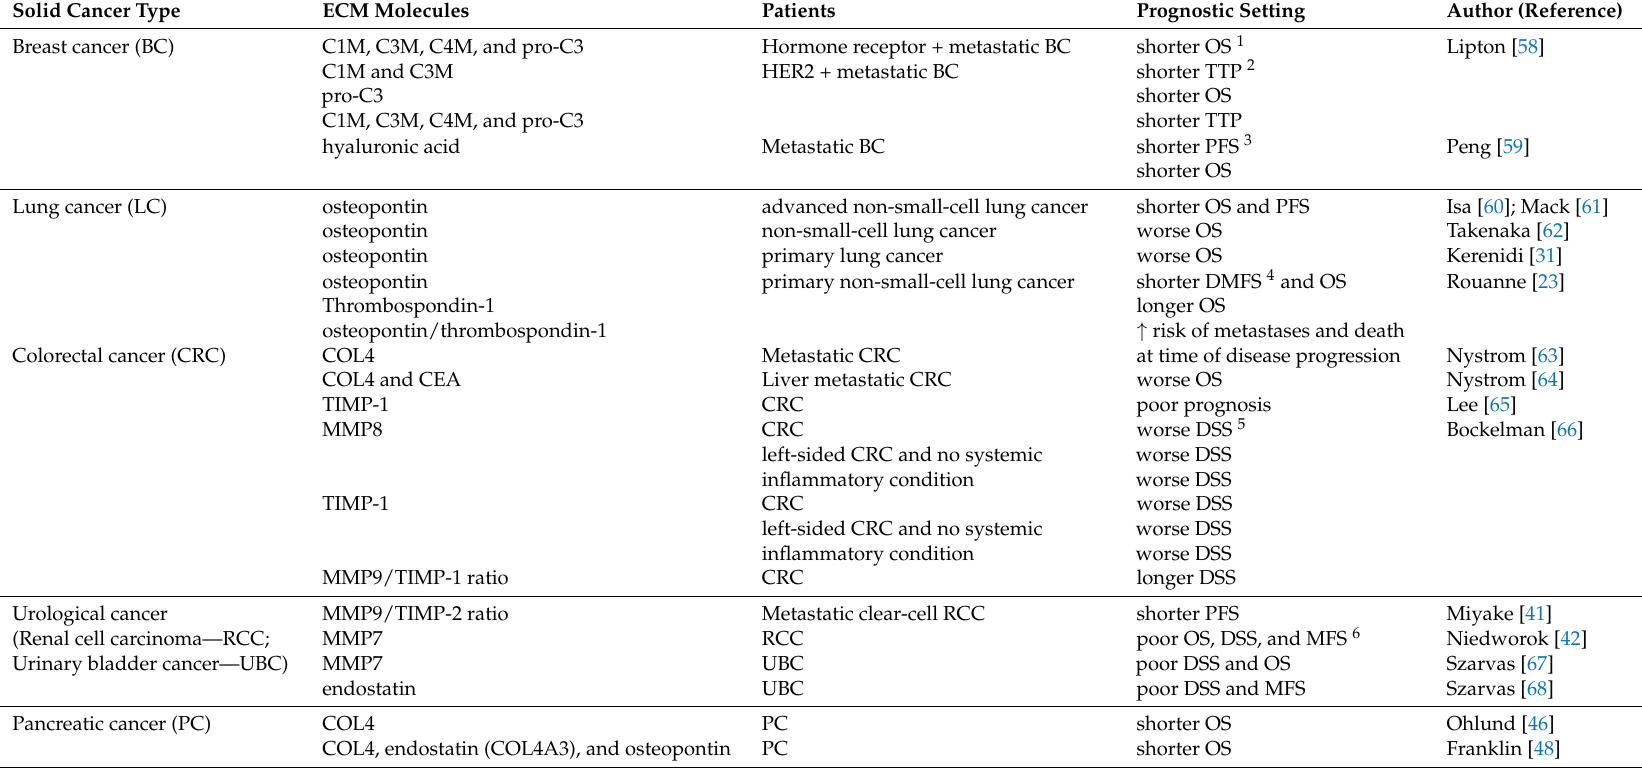
Table 2. ECM-derived molecules in cancer